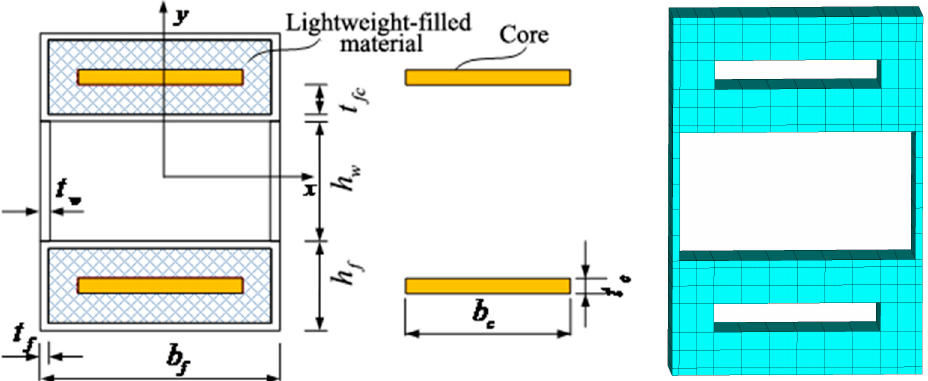
Figure 3. Section of the CSA-BRB.